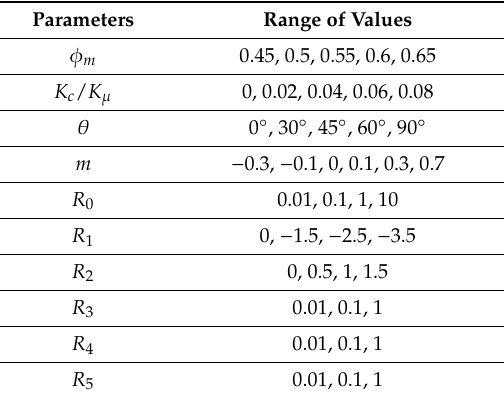
Table 1. Values of the dimensionless numbers and other